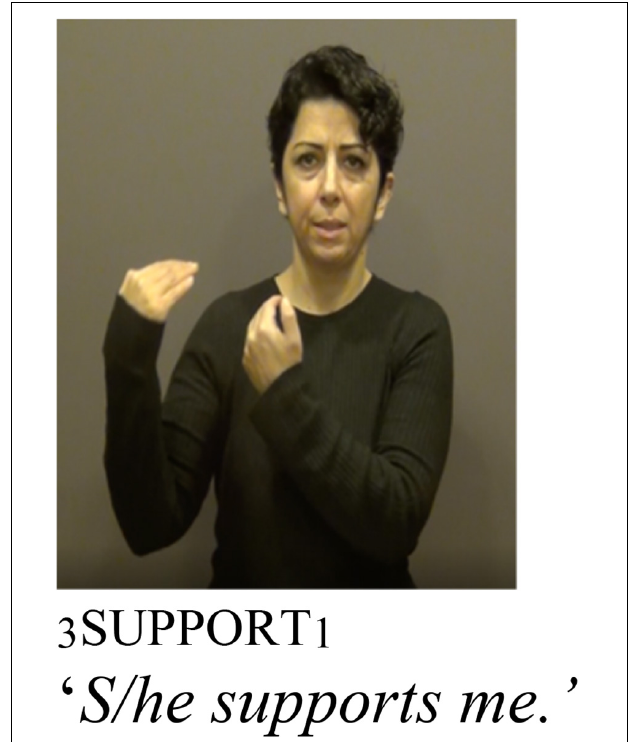
FIGURE 6 | Adapted with permission from Kelepir (2020c: P4,